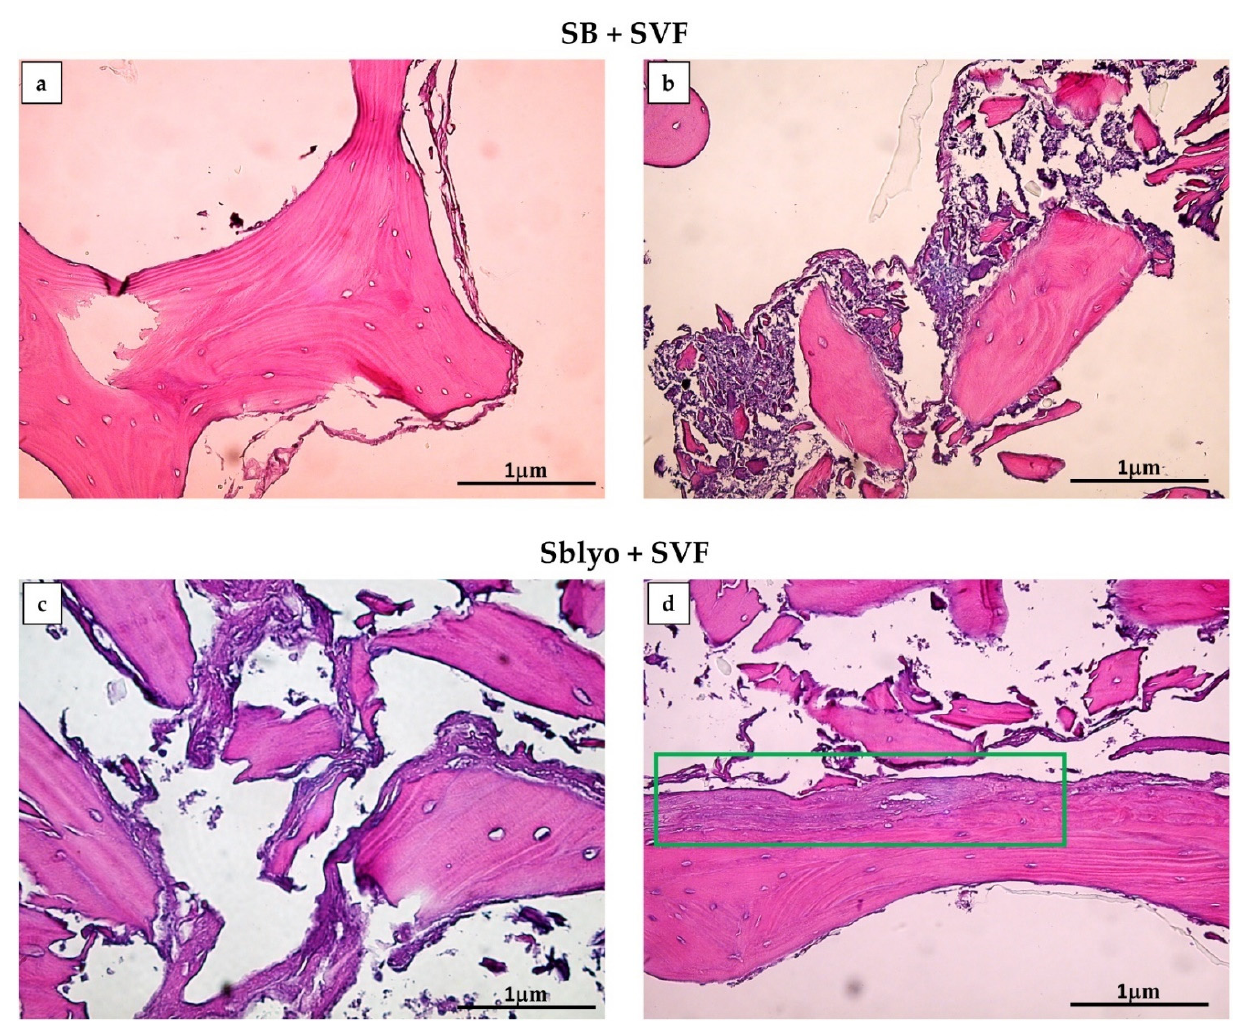
Figure 5. H&E staining. New tissue formation is evident on both SB ( a , b ) and SBlyo ( c , d ) after 60 days of culture. Panels ( a , b ) show cell growth in the periphery and among bone trabeculae, respectively. On SBlyo ( d ), a well-organized tissue portion is visible. The green rectangle indicates an area with well-organized neo-formed tissue. Magnification 20×. Scale bar: 1 µm.